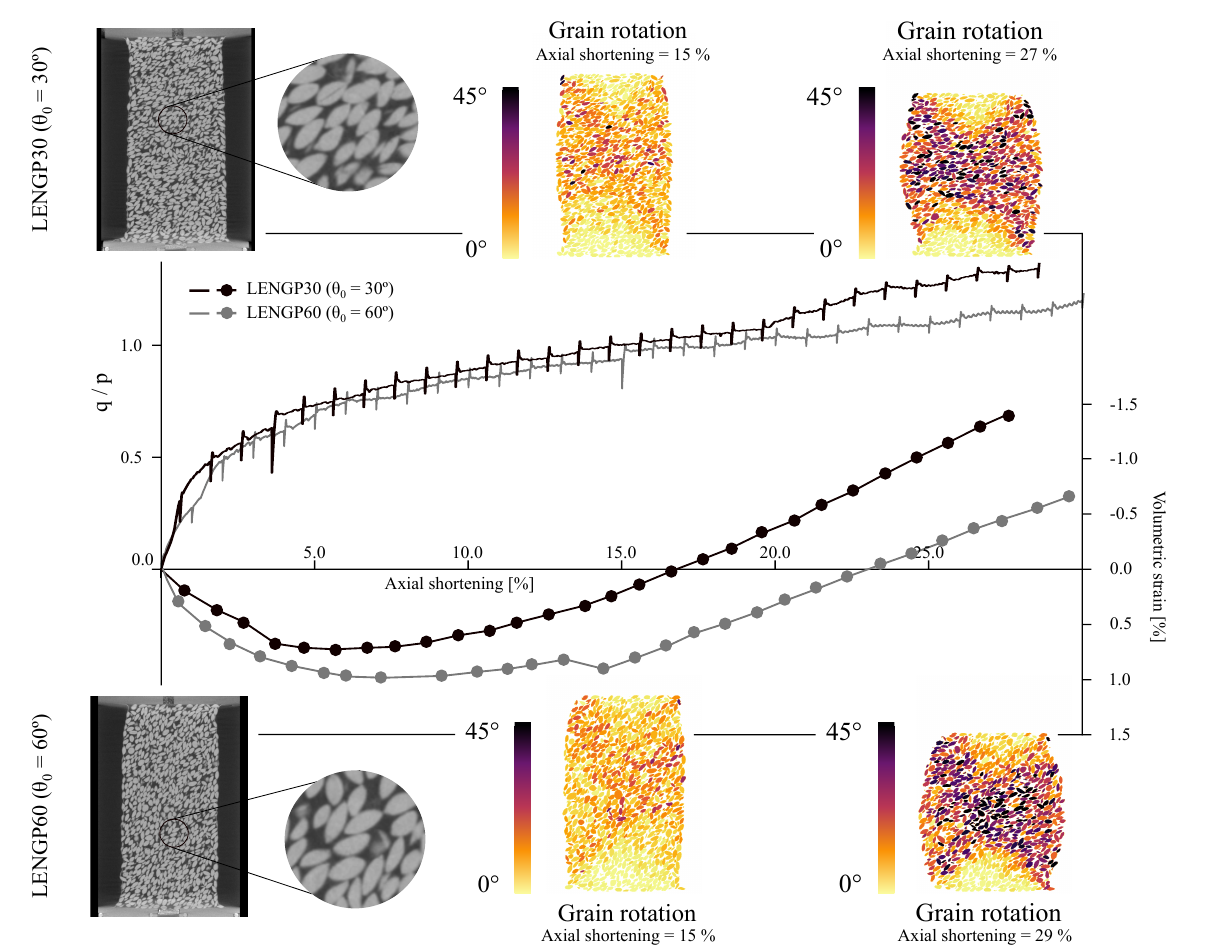
Figure 2: Stress ratio q / p and volumetric strain with respect to axial shortening